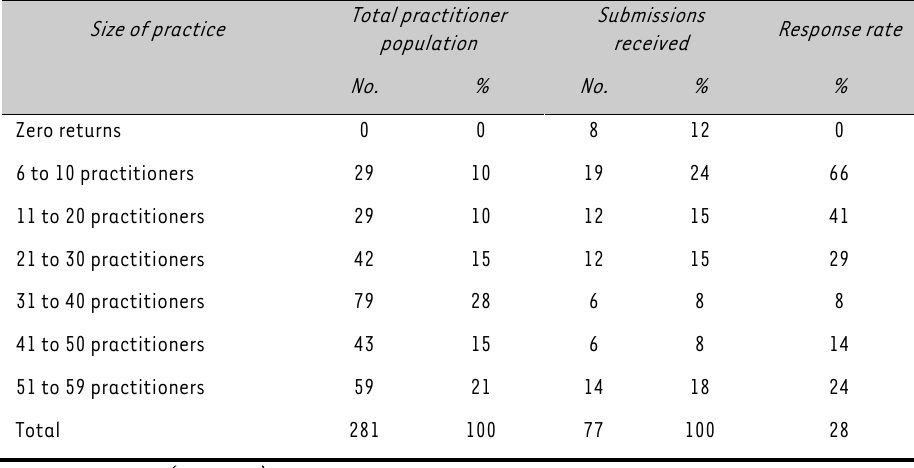
TABLE 1: Research response rates of the empirical research Size of practice